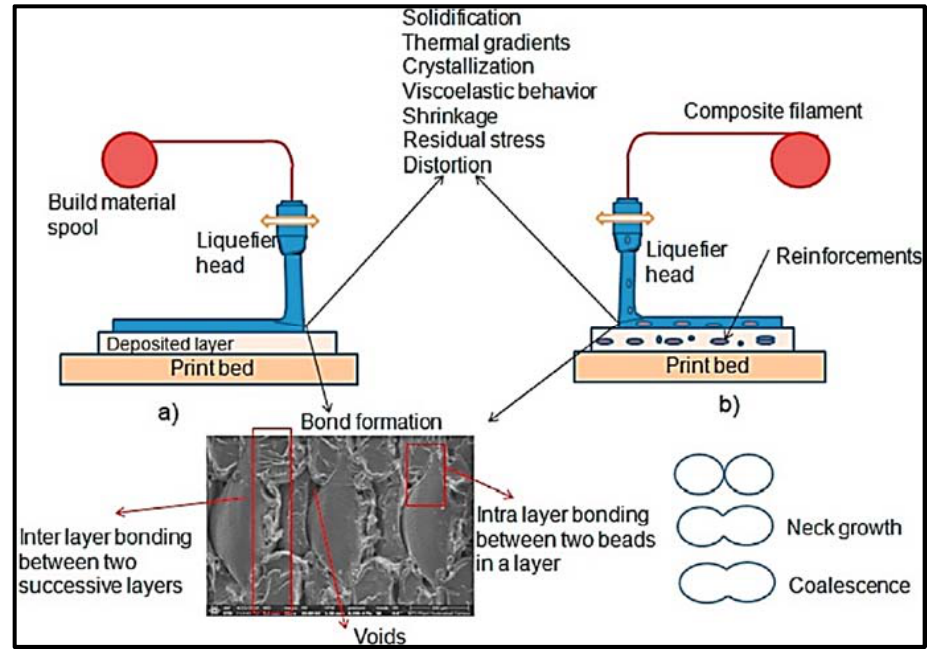
Figure 1. Schematic representation of the FDM process: ( a ) 3D printing of neat polymer; ( b ) 3D printing of polymer reinforced with particle fillers or short fibers [6] (reprinted with kind permission from Elsevier).